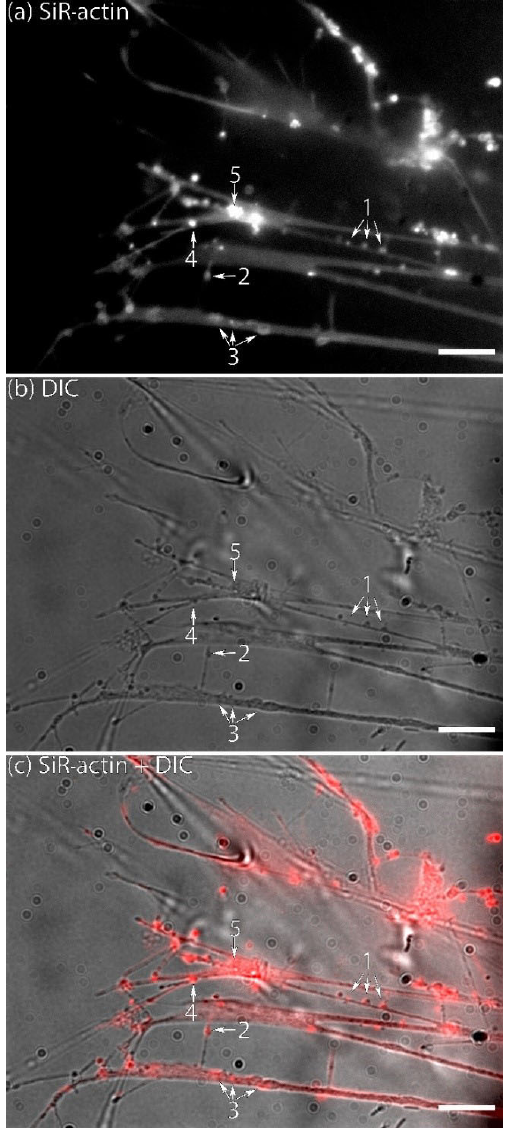
Figure 2. Pseudopodia of living Ammonia sp. attached to glass: (a) conventional fluorescence of SiR-actin-labelled structures, (b) DIC image of the same area, and (c) merged image of fluo- rescence and DIC channels (since the reticulopodia were moving, the DIC image is slightly shifted in relation to fluorescent one). Weak but non-uniform actin labelling following all membranes can be seen in pseudopodia. The number indicate the following ob- jects: 1 – group of three SiR-actin-labelled granules (ALGs) trans- ported along one thread of pseudopodia; 2 – actin in the tip of thin filopodium; 3 – larger SiR-actin-labelled areas showing smudgy flu- orescence weaker than in most ALGs; 4 – single ALG in bifurcation of reticulopodia; 5 – a group of very bright densely packed ALGs in the thick reticulopodium. Conventional fluorescence images were obtained with a Zeiss Axio Observer Z1 (scale bar